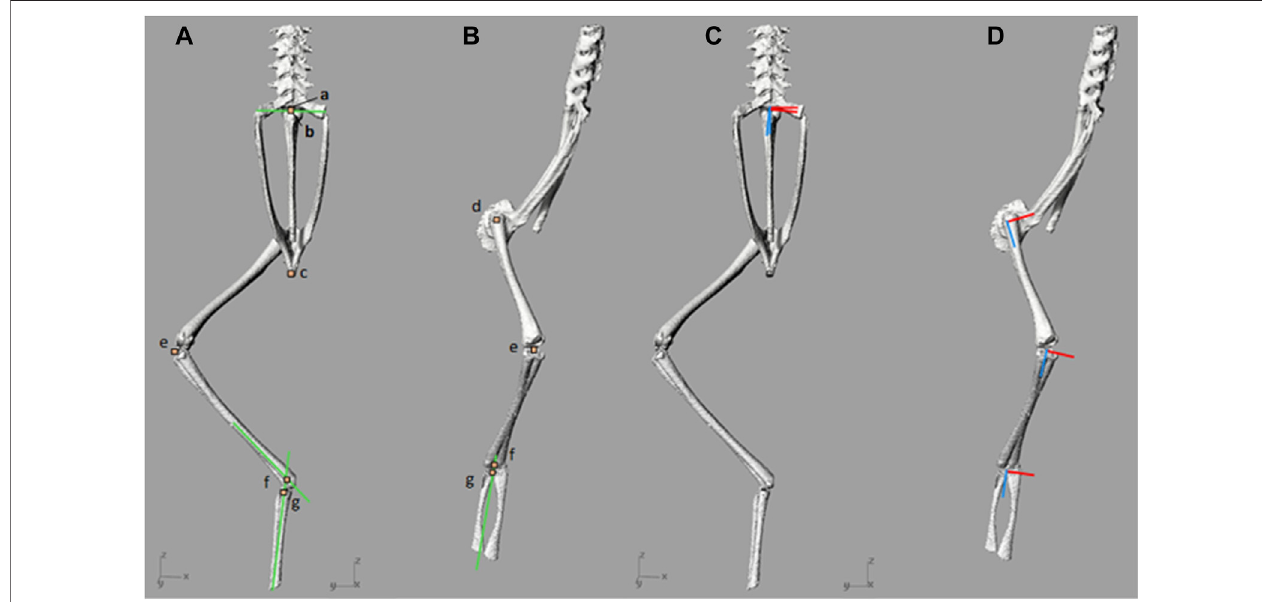
FIGURE 2 | (A,B) — Local origins and approximate joint centres of rotation, and (C,D) — joint local axes. Joint origins and approximate centres of rotation are denotedbyorangesquareswhichhavebeenenlargedforvisualisation.Markera)includesthelocaloriginforthespineandtheurostyle,aswellasthesacro-urostylicjoint centreofrotation. Markerb) representsthe sacroiliac joint centre ofrotation.Marker c) represents the pelvic localorigin. Marker d) includes the femur localorigin and the hipjointcentreofrotation.Markere)includesthetibio fi bulalocaloriginandthekneejointcentreofrotation.Markerf)representstheanklejointcentreofrotationand marker g) represents the tarsal segment local origin. The green lines present in (A) and (B) are the reference lines used to fi nd SI and ankle joint centres ofrotation. In (C) and (D) , the X axes are red and Z axes are